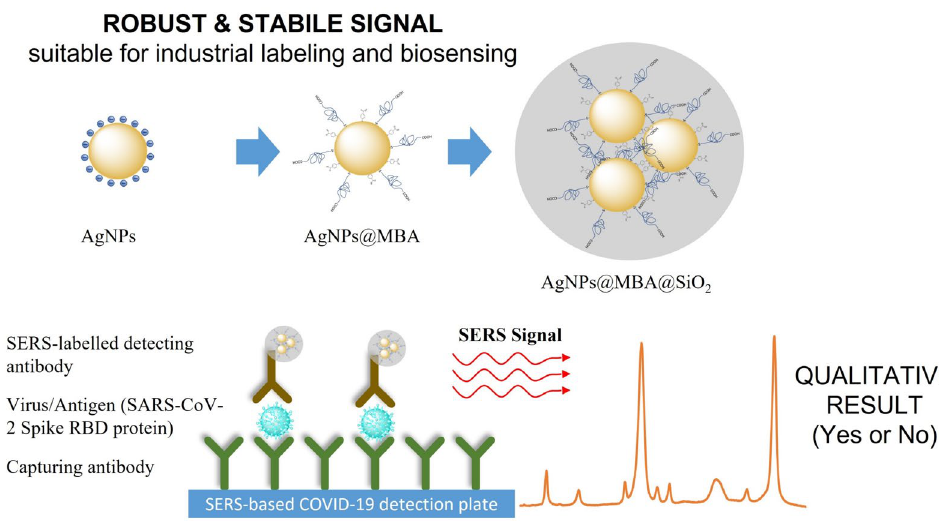
Figure 4. Scheme of the rational and controlled synthesis of robust and stabile SERS encoded plasmonic-silica nanocomposites for enhanced, fast, sensitive, and selective labeling and